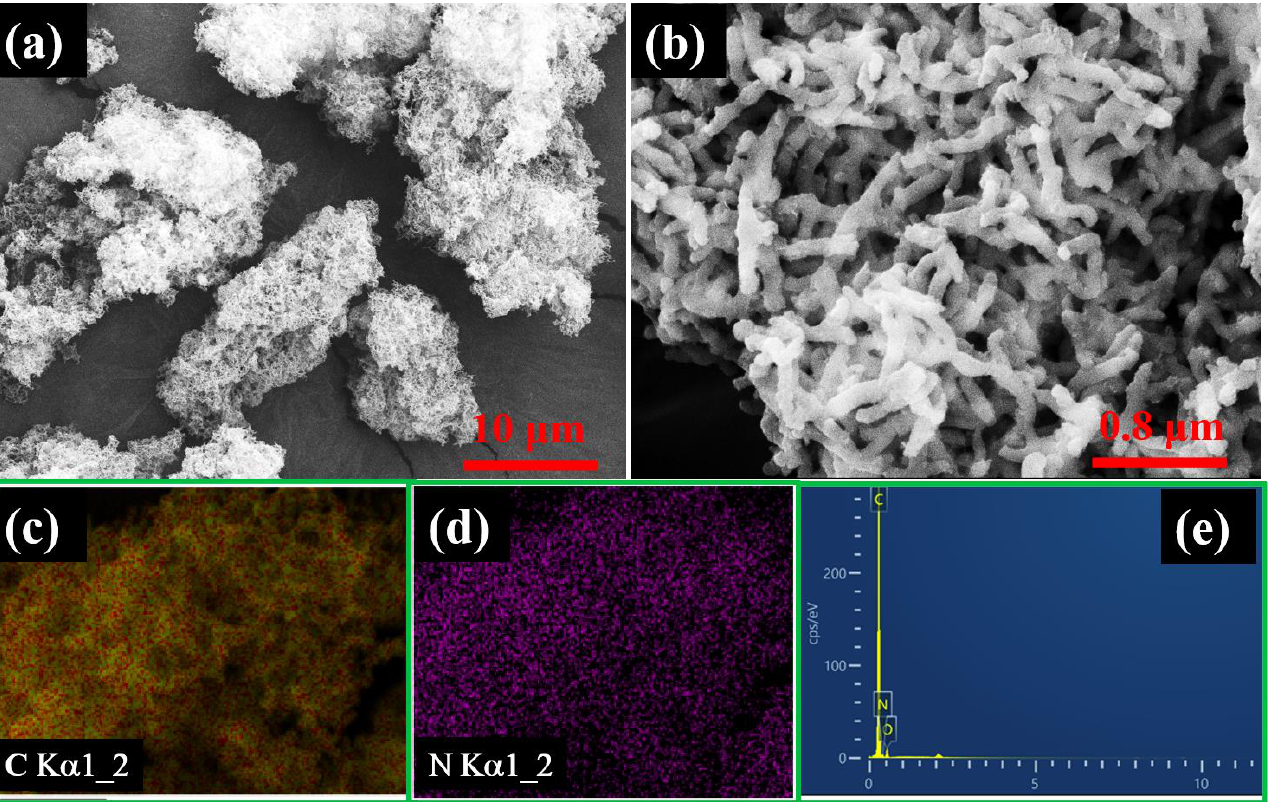
Figure 3. SEM images of the as-prepared PANI-OH-3 composites with different sizes ( a , b ) and the corresponding EDS elements mapping ( c – e ).